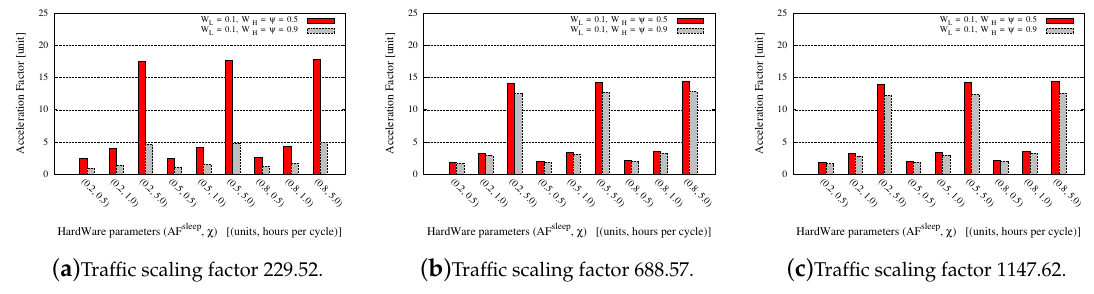
Figure 11. AF after 14 days vs. the HW parameters with | T low | = 72, | T inc | = 36.